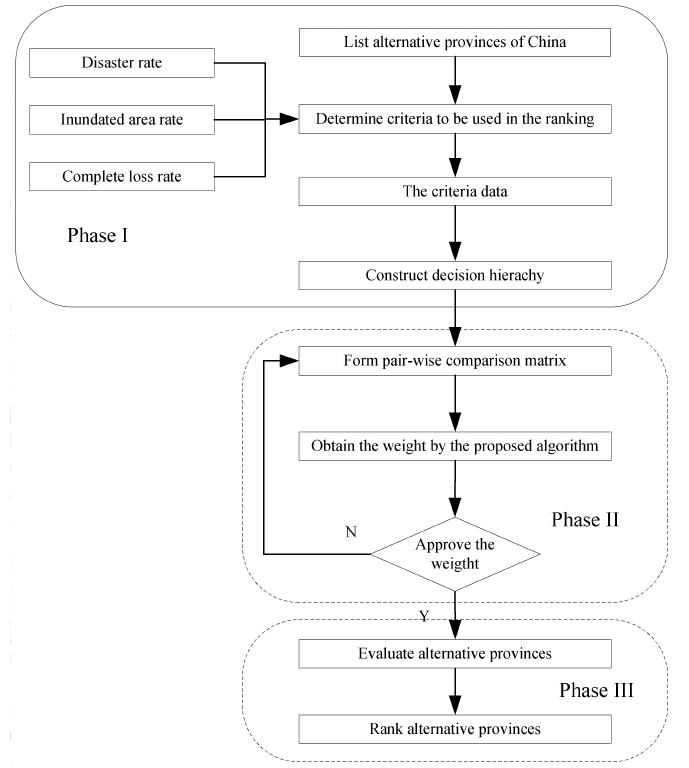
Figure 1. The proposed